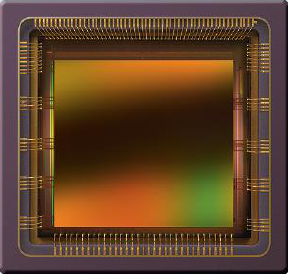
Figure 11. The chip of the designed novel 9T GSI pixel after packaging.